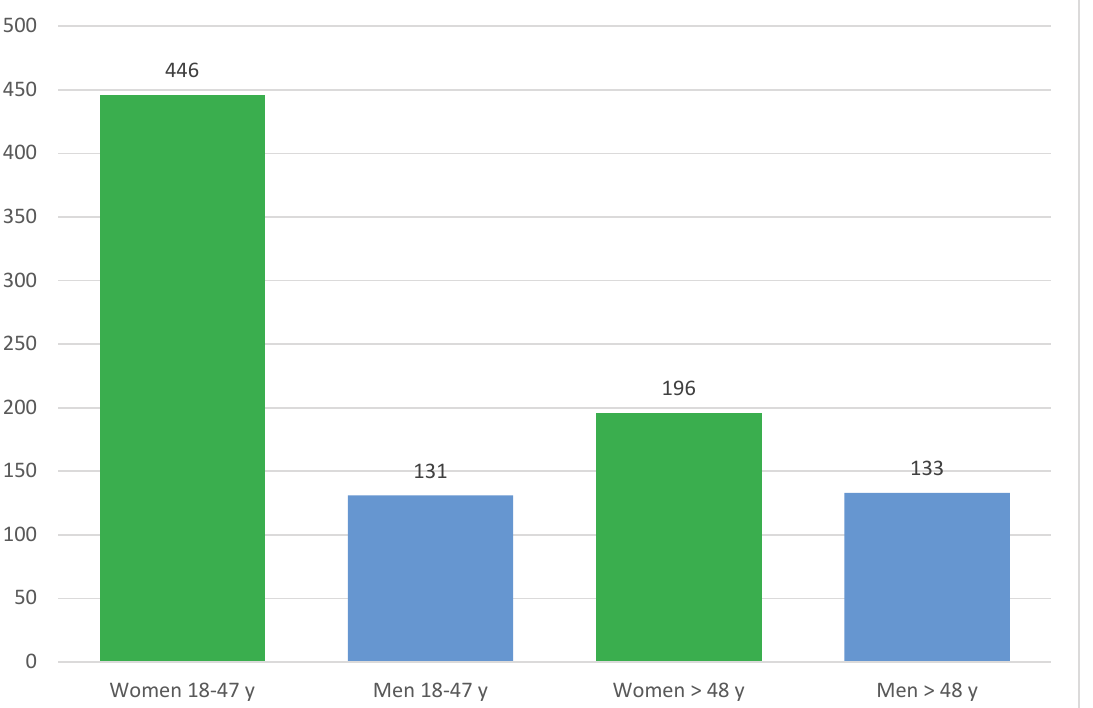
Figure 2. Distribution of the sample according to age groups and gender ( n = 906).